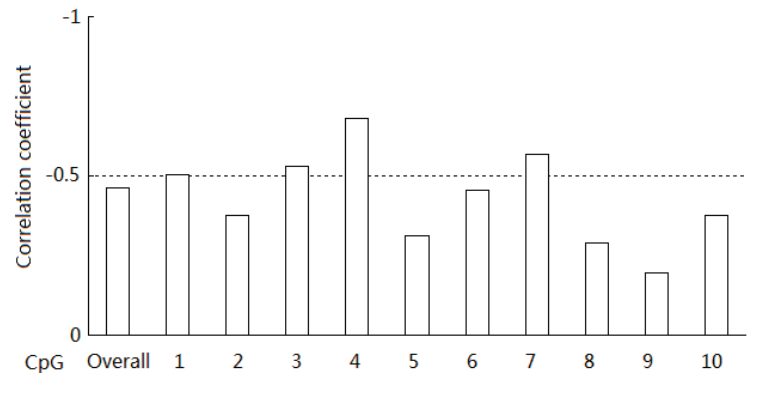
Figure 3. Correlation analysis of methylation levels and mRNA expression at different CpG sites in the porcine BPI gene CpG